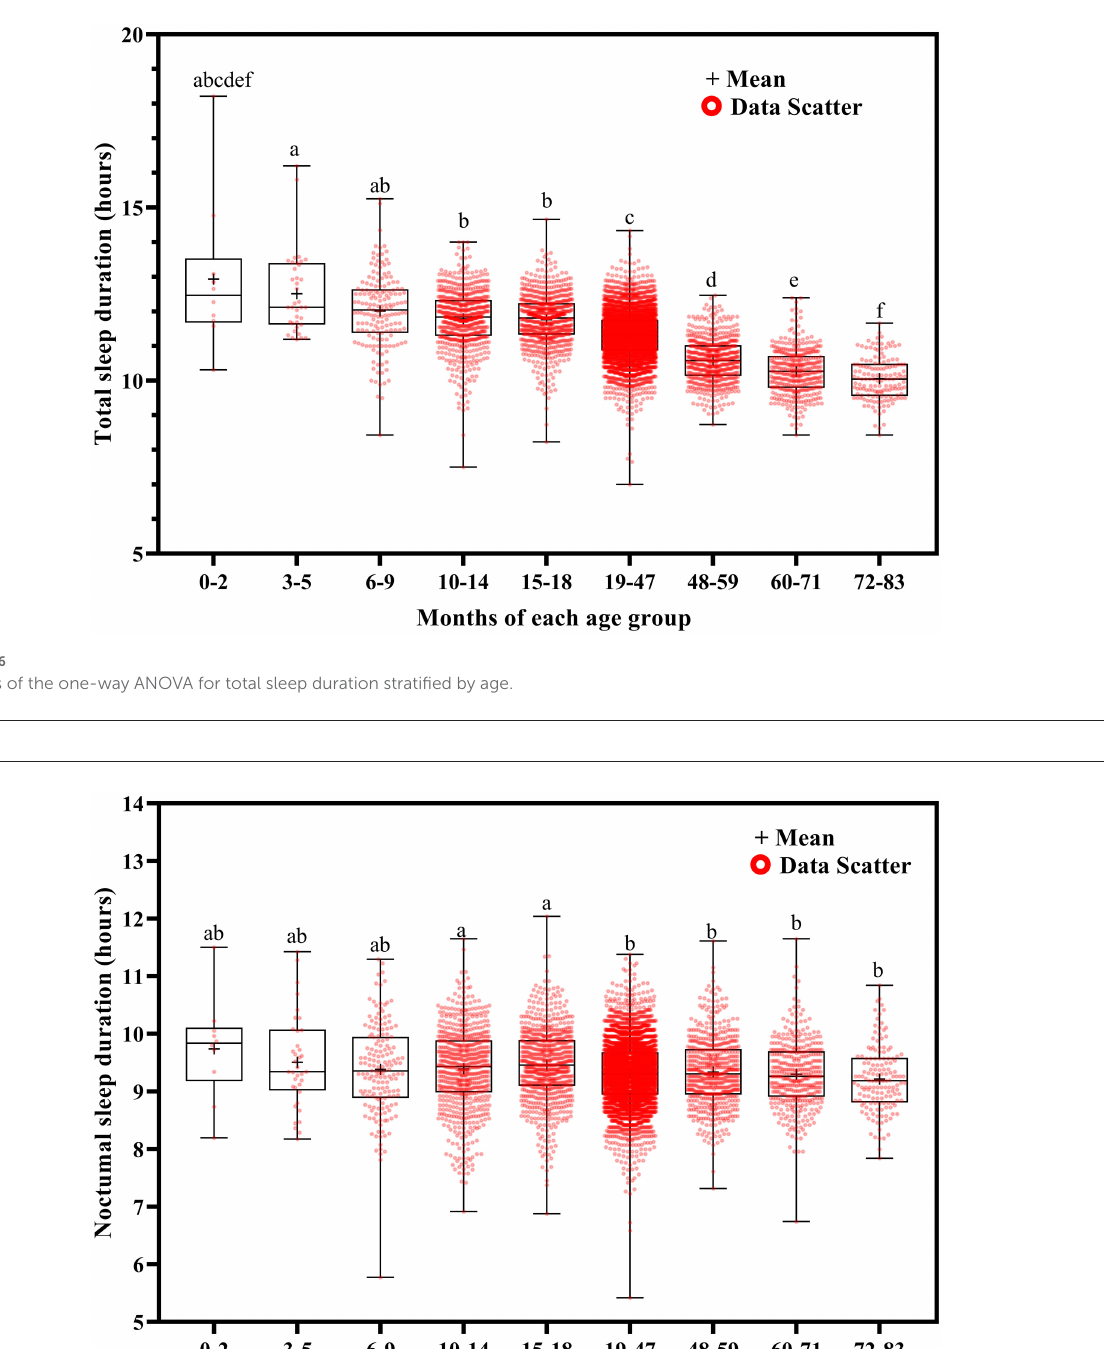
months; at ages 6–9 months than at ages 10–83 months ( p < 0.001); at ages 10–14 months than at ages 15–83 months ( p < 0.001); at ages 15–18 months than at ages 19–83 months